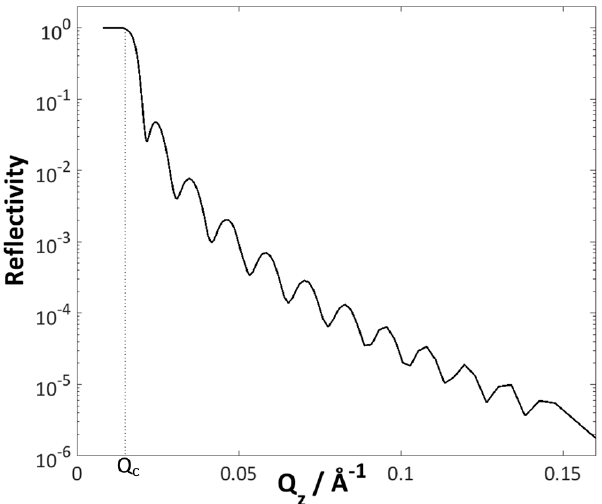
Figure 2. Representative simulation of neutron reflectometry data, illustrating the total reflection at low Q and the fringes that arise from an adsorbed layer at higher Q . The critical edge is marked as Q c . The simulation also illustrates the characteristic fringes that arise from the presence of a deposited layer at the surface. These fringes arise from interference from reflection at the two interfaces that bound the thin film. The period of the fringes is therefore related to the film thickness and their amplitude to the composition of the thin film. In some cases where the films are very thick, the calculation of the reflected signal is more complex [31,56,57]. However, for the corrosion-related work discussed here, the thin film approximation is almost universally used.